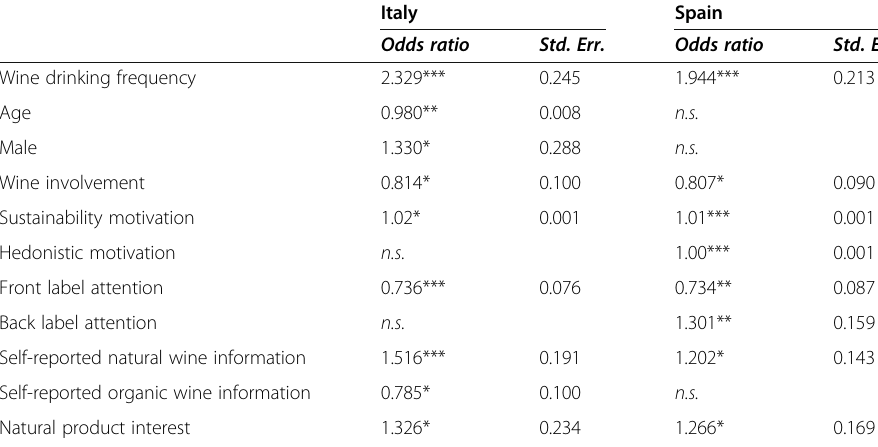
Table 6 Odds ratio of the selected coefficients (95%